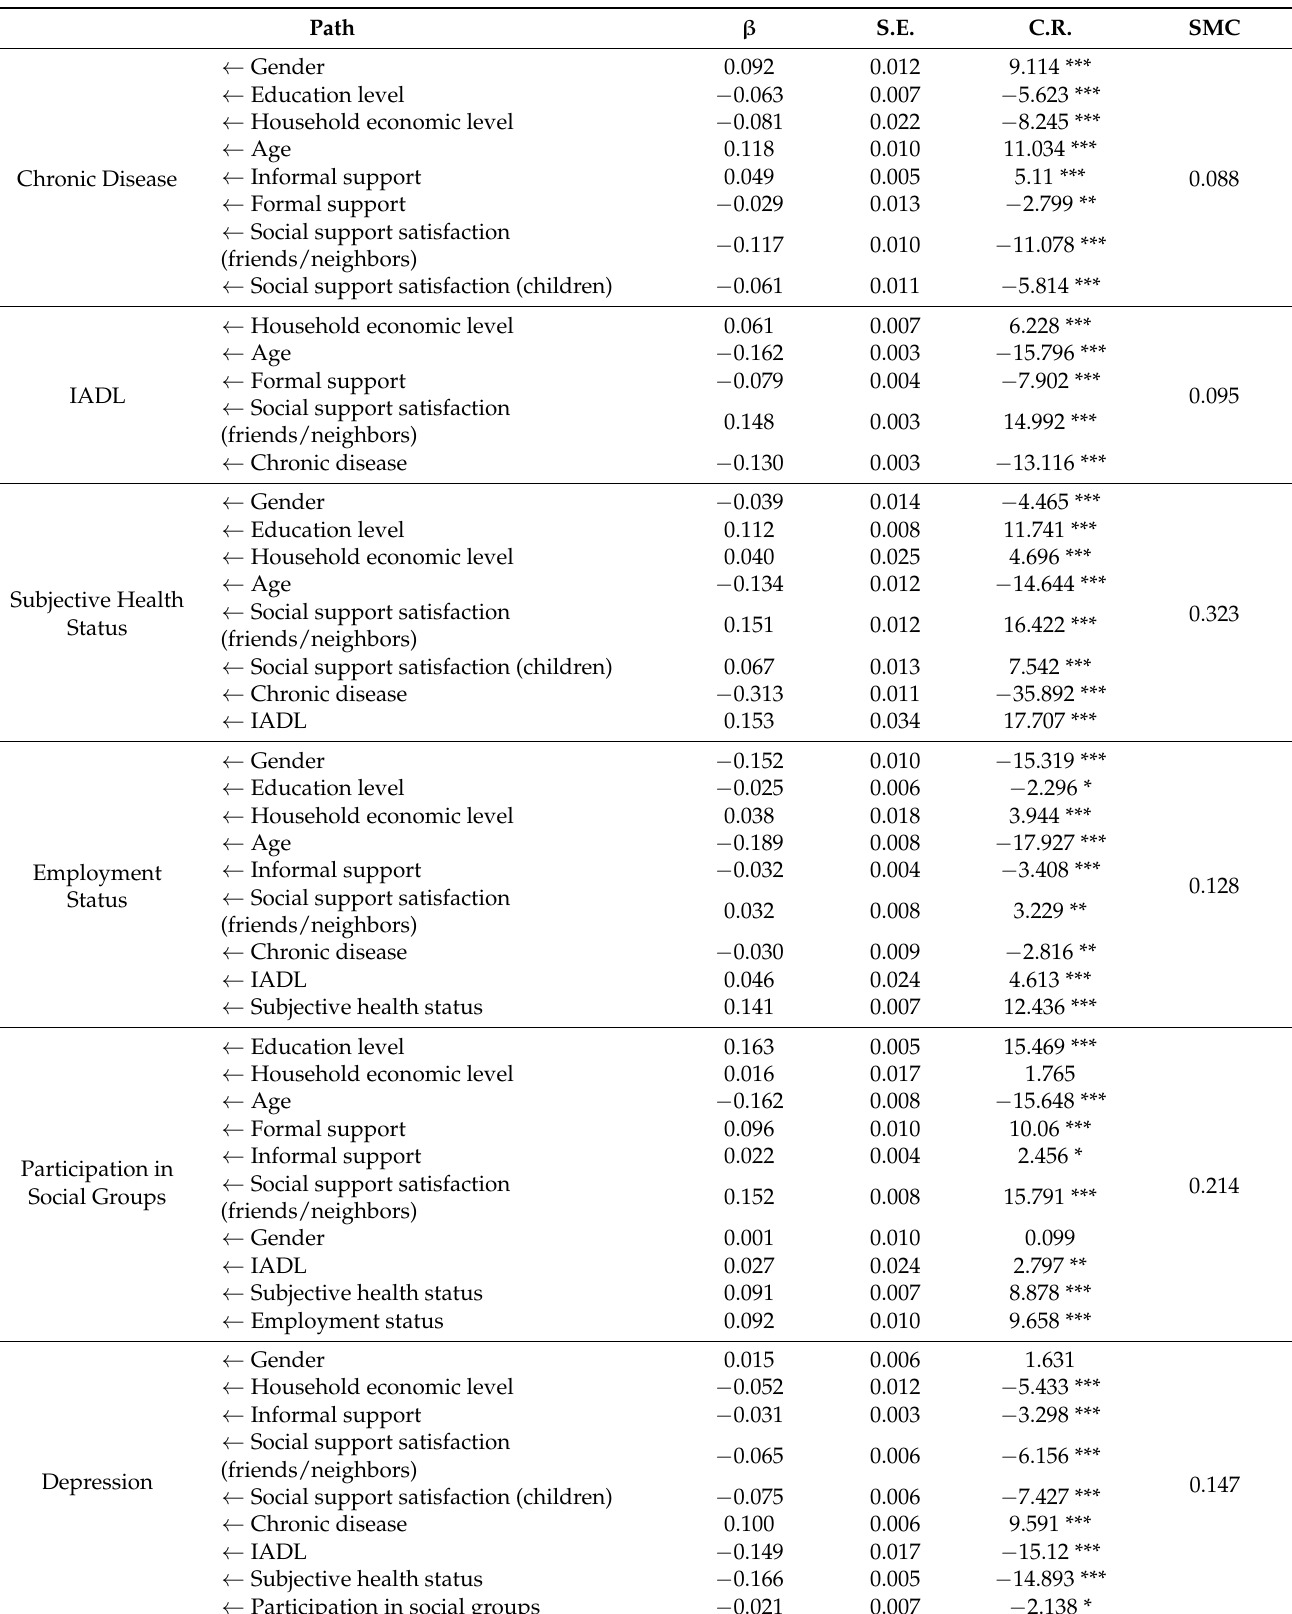
Table 3. Standardized coefficient and squared multiple correlations (SMC) of the predictive model.